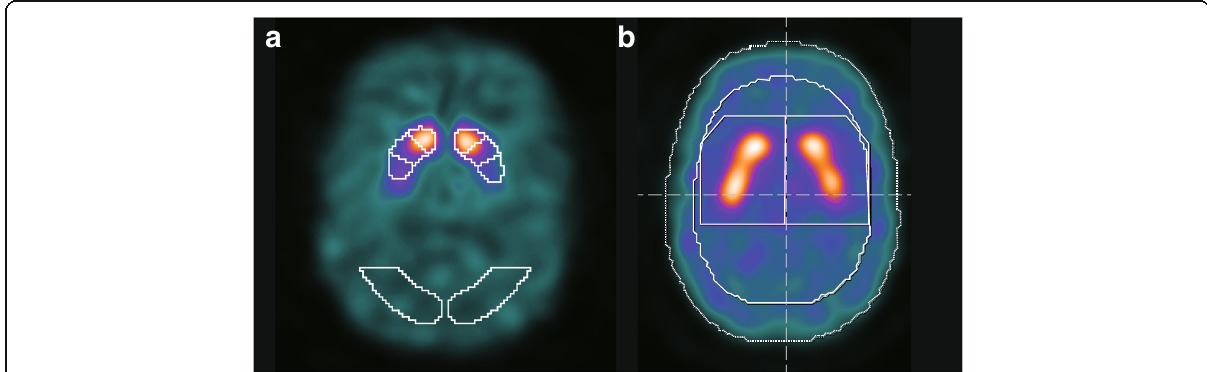
Fig. 1 Two types of VOI settings using DaTQUANT and DaTView. a DaTQUANT uses separated VOIs delineated to fit to the striatum. The reference VOIs are set to the bilateral occipital lobes. b DaTView uses large pentagonal prism-shaped VOIs encompassing a wide area around the striatum. The reference VOI is set to the whole brain. Abbreviation: VOI, volume of